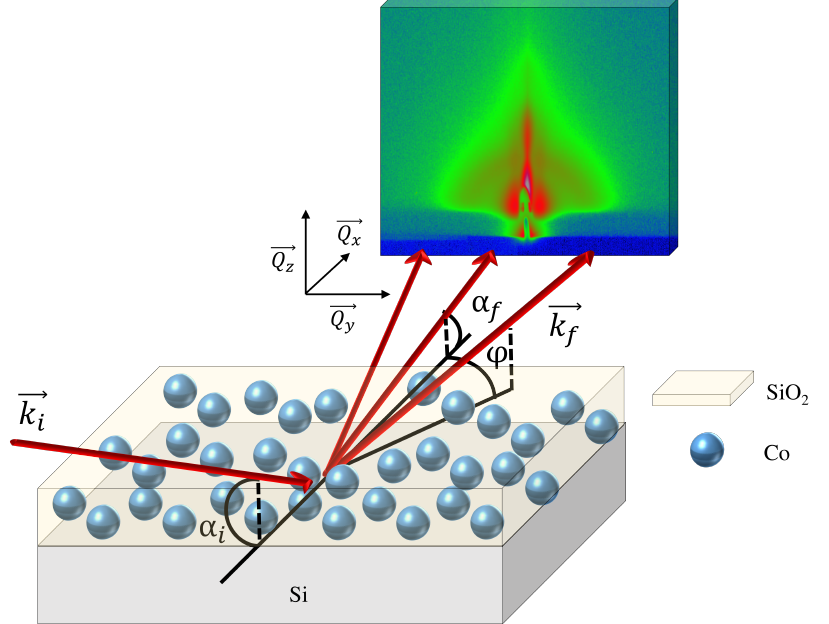
Figure 2. Geometry of the GISAXS experiment: k i and k f are the wave vectors of the incident and scattered beams, respectively; α i , α f and ϕ angles determine the momentum transfer components Q x , Q y , Q z